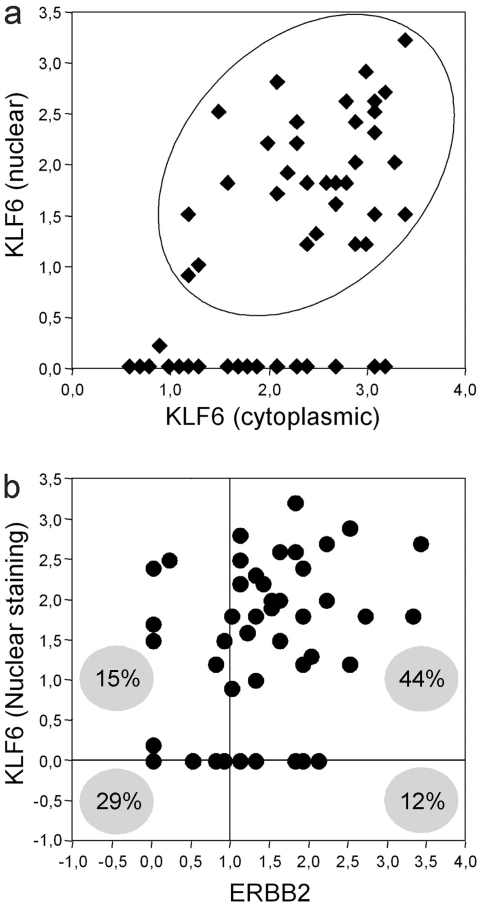
Association between nuclear KLF6 expression and ERBB2-overexpression in ductal breast tumor tissues.The immunohistochemical staining intensity for KLF6 (nuclear and cytoplasmic) and c-erbB2 (cytoplasmic membrane) is represented as scores used a 0.0–4.0 scale estimated over a characteristic cell cluster of each tissue. The scores estimation was obtained as described [50], [51] (see Material and Methods). A score of 1.0 represent less than 10% of positive labeled cells and was set as the cutoff value. A. Scatter plot analysis of nuclear KLF6 versus cytoplasmic KLF6. The oval includes positive tissue for both staining patterns. B. Scatter plot analysis of nuclear KLF6 versus ERBB2 immunostains. Filled lines settled at 0.0 and 1.0 score indicate cutoff values and partite four populations determined by the KLF6 and ERBB2 staining. The percentage of each population is represented into a gray circle. Especially for the double-negative population (minus 1.0 and 0.0 scores) a point could represent two or more cases.